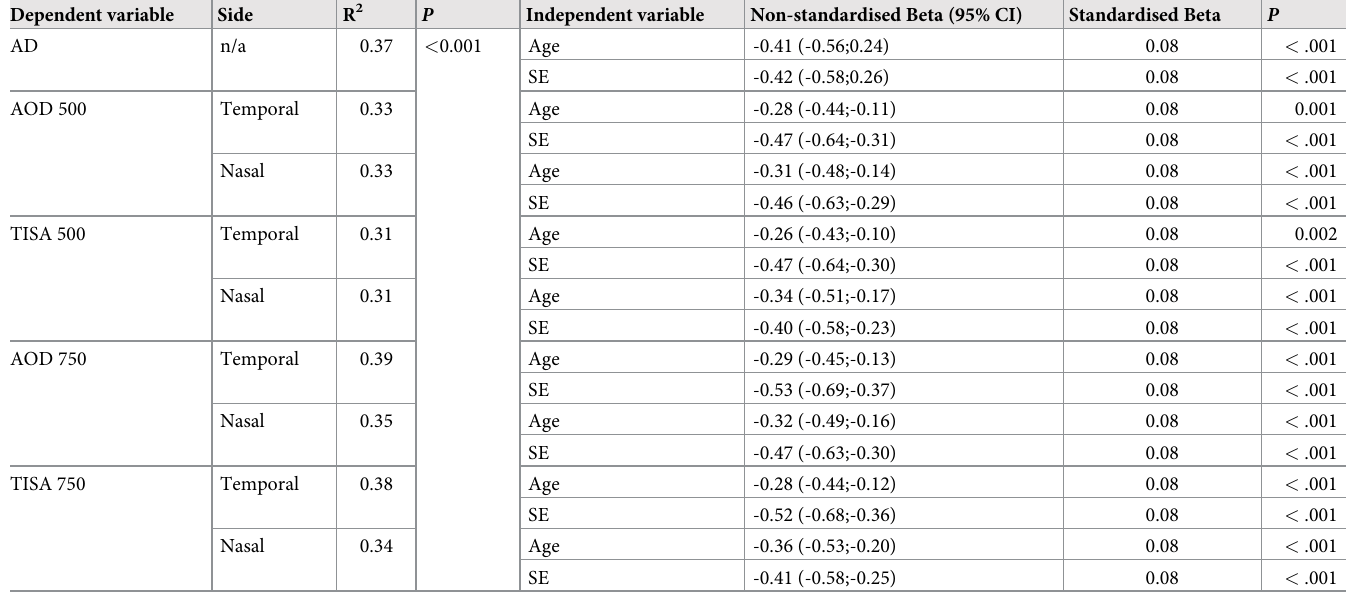
Table 4. Multivariable linear regression analysis of the relationship between age and spherical equivalent refractive error to aqueous depth, angle opening distance and trabecular space area at temporal and nasal side of horizontal AS-OCT scan. Dependent